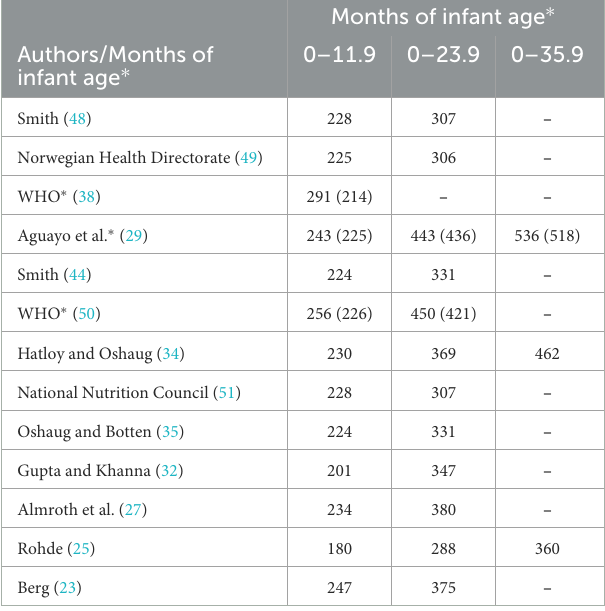
TABLE 2 Average volume (liters) of human milk intake by a child and by month of age in studies on economic value of breastfeeding. Months of infant age